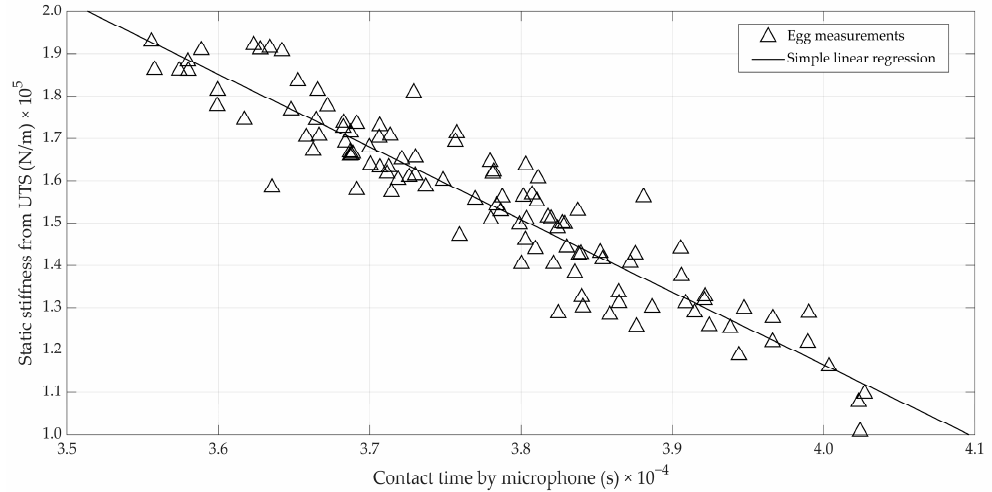
Figure 6. Relation between the static stiffness measured during quasi-static compression and the contact time between impactor and ball, measured by the microphone.